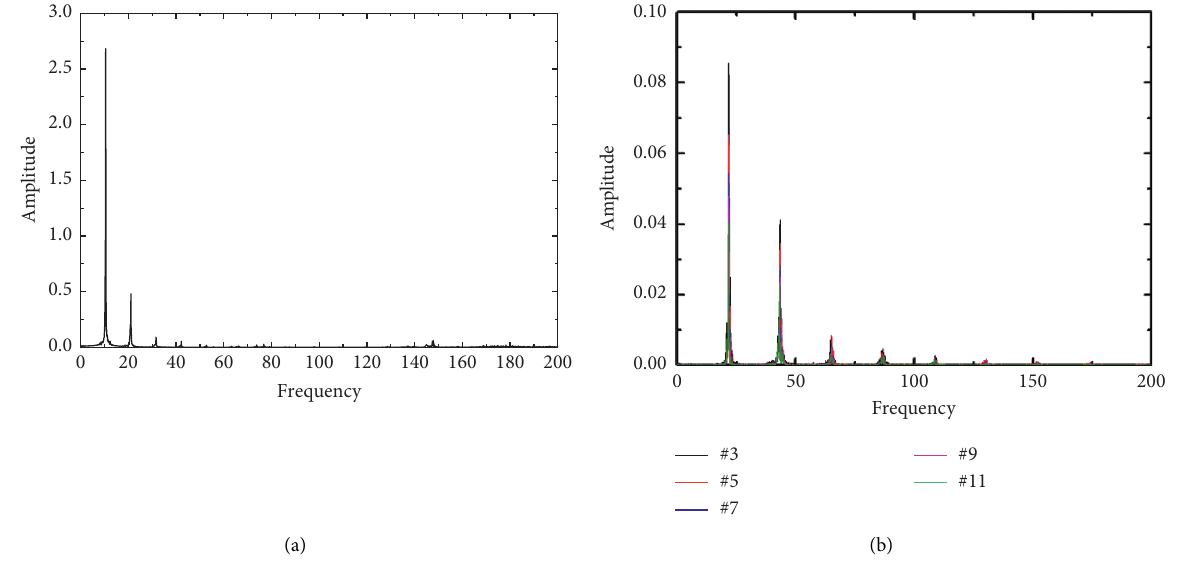
Figure 10: Distribution of Fourier spectrum in vertical direction: (a) Fourier spectrum of #1 measuring point; (b) Fourier spectrum of #3, #5, #7, #9, and #11 measuring points.